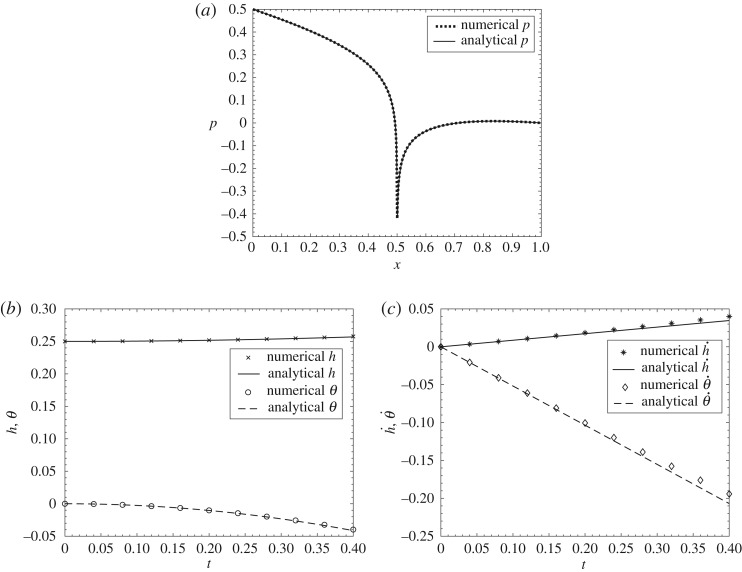
Comparison between small-time analytical solutions and numerical solutions for M^=0.5, g^=0.24 at early times (a) pressure at time t = 0 + , (b) h and θ against t, (c) h˙ and
θ˙ against t.